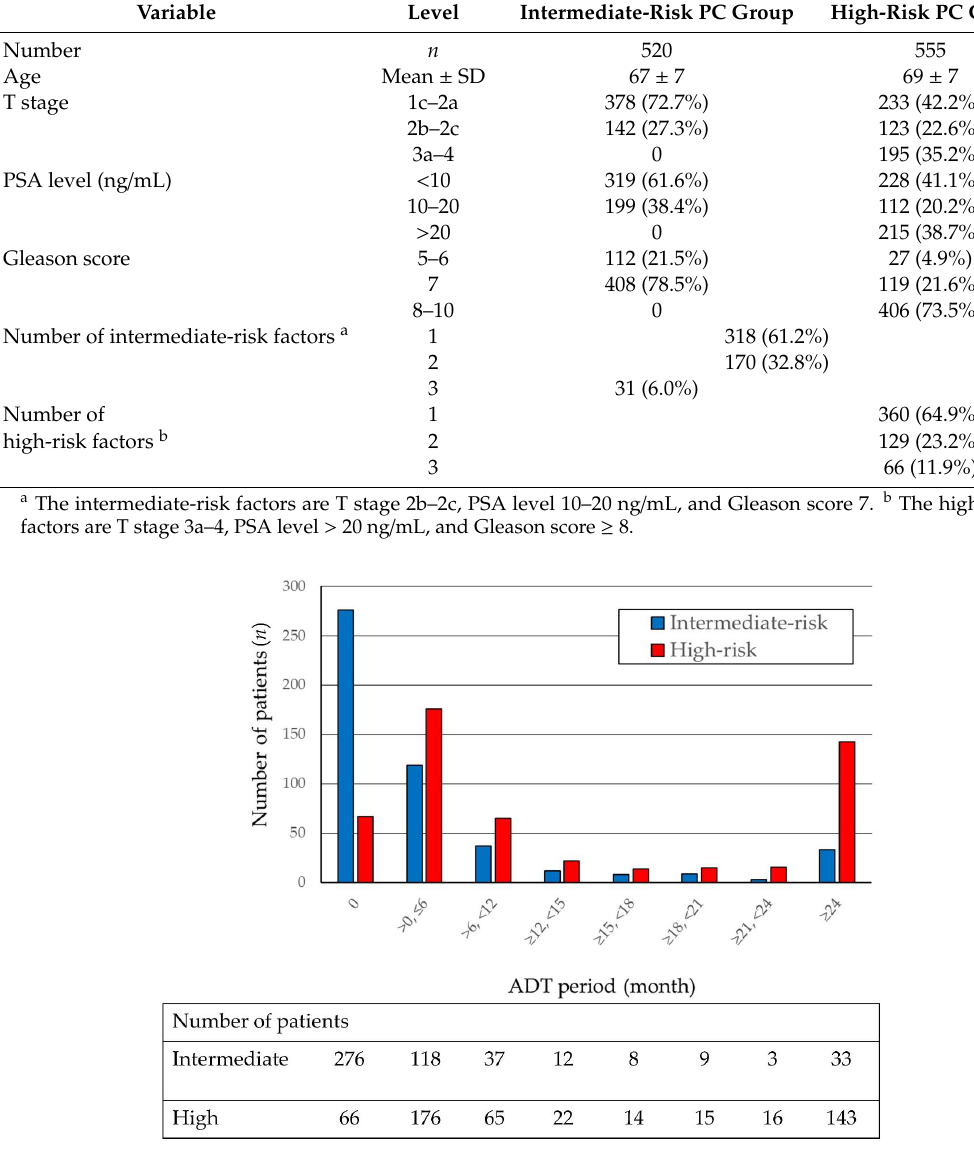
Figure 1. Number of patients according to androgen deprivation therapy (ADT) duration. Table 1. Patient characteristics according to the National Comprehensive Cancer Network risk classification.